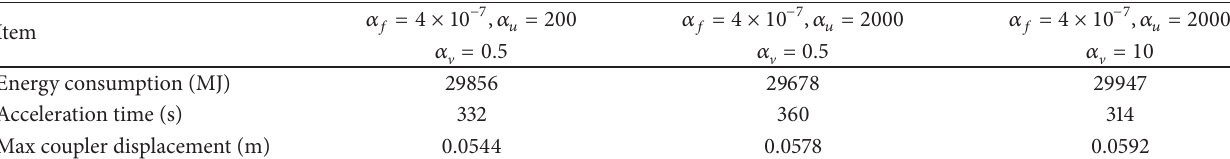
Table 2: The simulation results with different control